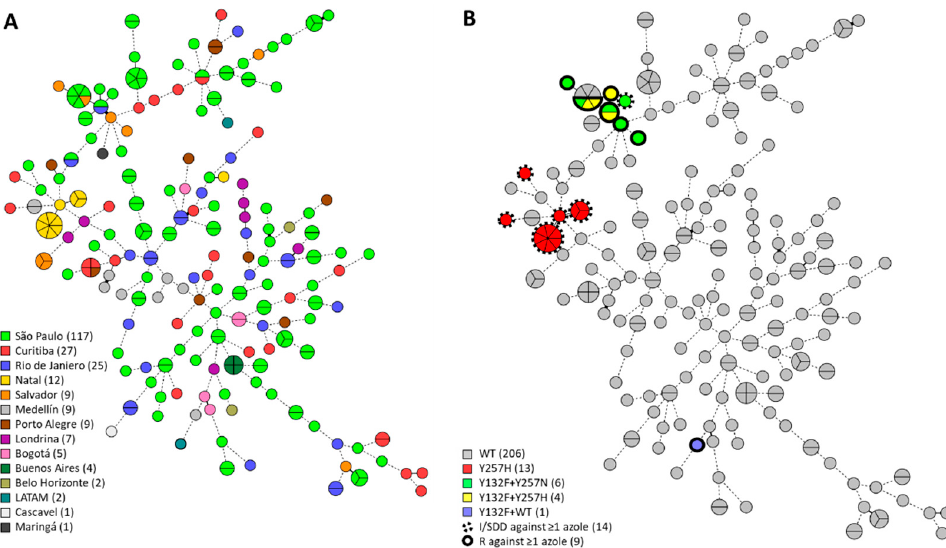
Figure 1. Minimum-spanning tree of 230 C. tropicalis isolates. Branch lengths indicate the similarity between isolates with thick solid lines (variation in one allele), thin solid lines (variation in two alleles), and thin dotted lines (variation in three or more alleles). Azole-intermediate and azole-resistant isolates are demarcated in dotted black lines and solid black lines, respectively. On the left ( A ), the number of isolates per city are shown in the color key; on the right ( B ), isolates with ERG11 substitutions and reduced azole susceptibility are shown as in the color key. LATAM, Latin American.